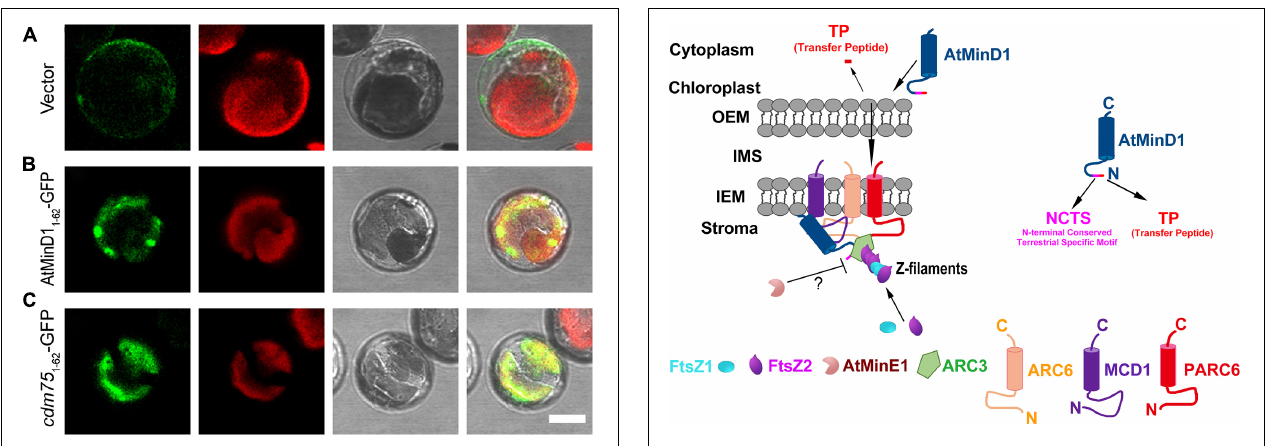
FIGURE 6 | Localization of AtMinD1 1 − 62 with GFP in arc6 protoplasts. Fluorescence micrographs showing the N-terminal fragment of AtMinD1 fused with GFP transiently expressed in mutant arc6 protoplasts, which include (A) GFP, (B) AtMinD1 1 − 62 -GFP, and (C) cdm75 1 − 62 -GFP. Scale bars = 10 µ m.